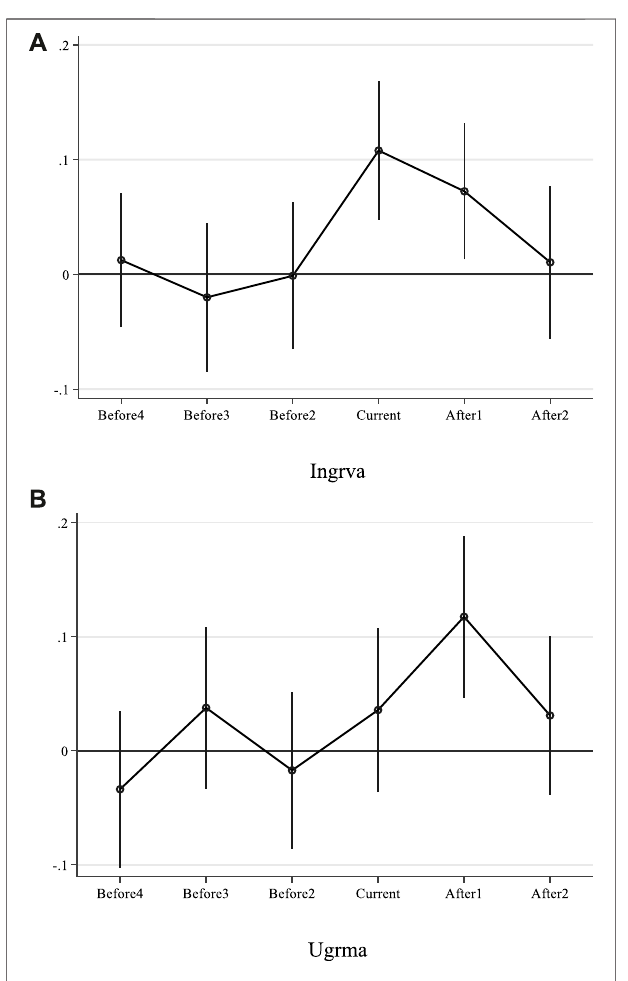
FIGURE 1 | Graphical representation of the results of the parallel trend test.